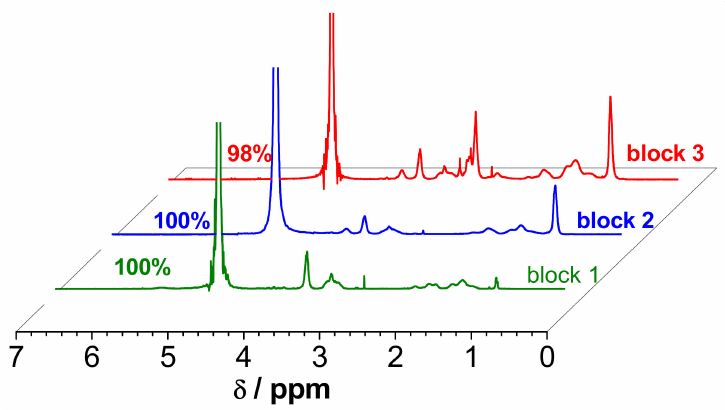
Figure 2. 1 H nuclear magnetic resonance (NMR) spectra (D 2 O) for triblock copolymers of HEAA, NIPAM and DMA and by iterative Cu(0)-mediated polymerization.